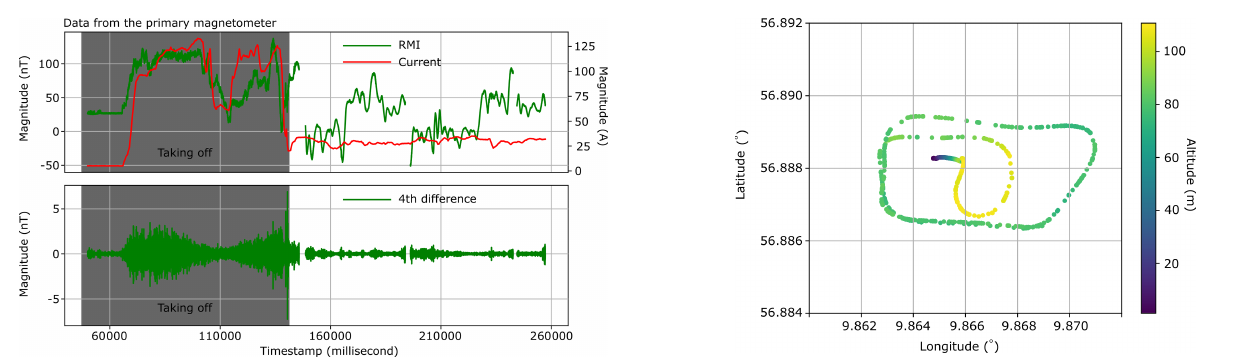
Figure 12. Data excerpt of RMI profile recorded by the primary magnetometer and its fourth difference, together with the profile of output current from the battery with d = 20cm and L = 30cm. The IGRF (50563nT) has been removed.